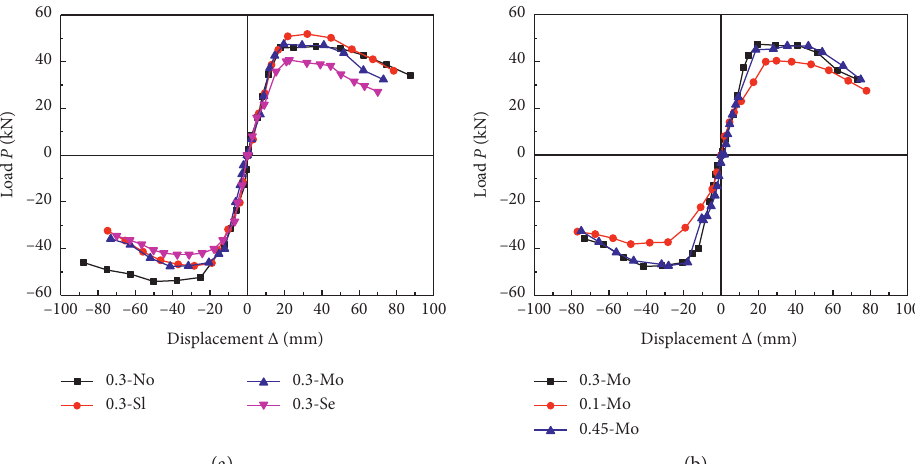
Figure 8: The backbone curves of specimens. (a) Corrosion-degree-induced changes in backbone curve. (b) Axial-compression-ratio- induced changes in backbone